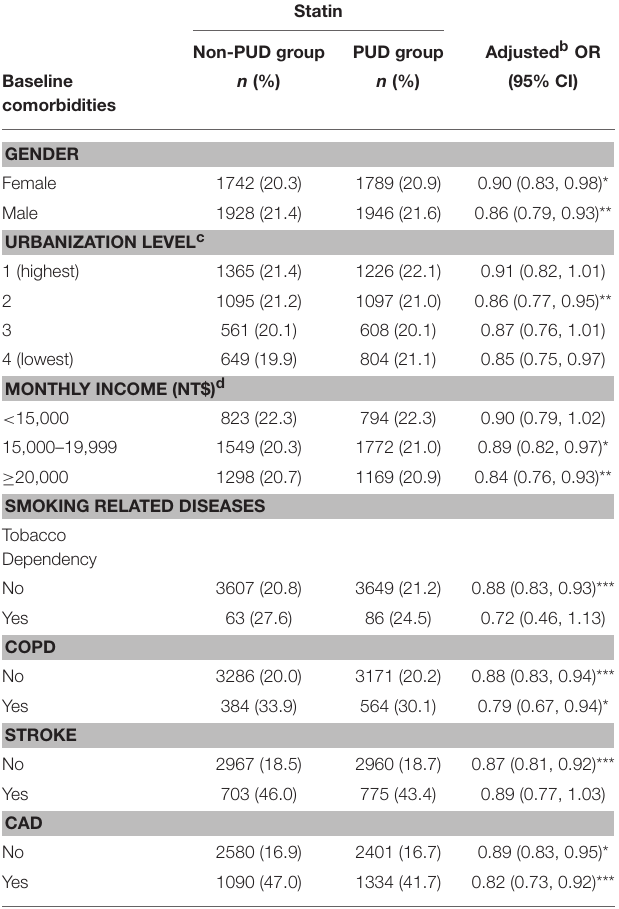
TABLE 4 | Logistic regression analysis measured the odds ratio for the study group stratified by sex, urbanization level, monthly income, and smoking related diseases a